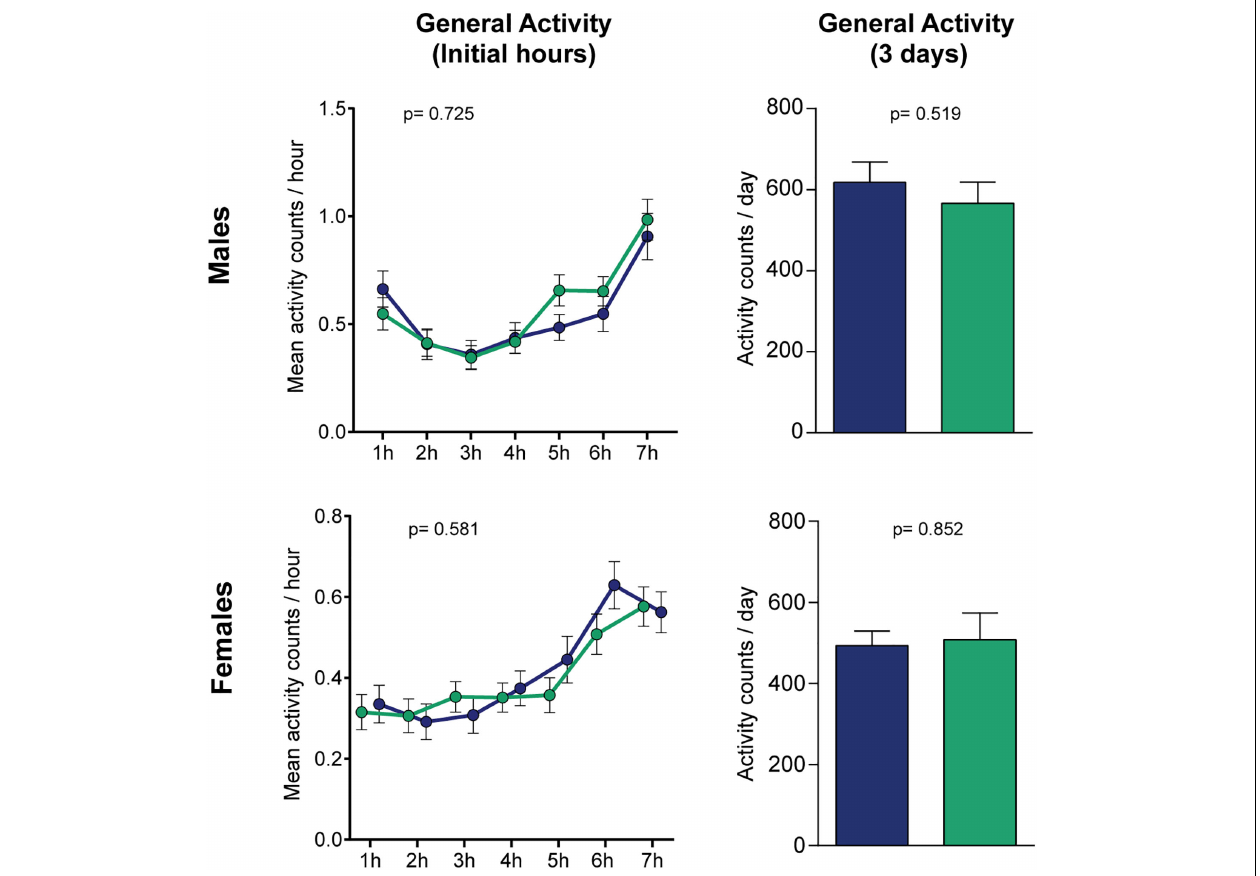
FIGURE 3 | Levodopa does not affect normal locomotion in flies. No statistical differences were found when measuring the activity in horizontal tubes, neither for the initial hours (left panels, treatment-effect p -values were calculated by two-way ANOVA) or the mean daily locomotion of the flies when measured for 3 days (right panels, p -values calculated by Student’s t test). Blue and green bars represent controls and L-Dopa treatment, respectively ( n = 64/32 and 59/16 control/treated flies for males and females). Bars and errors represent mean ±